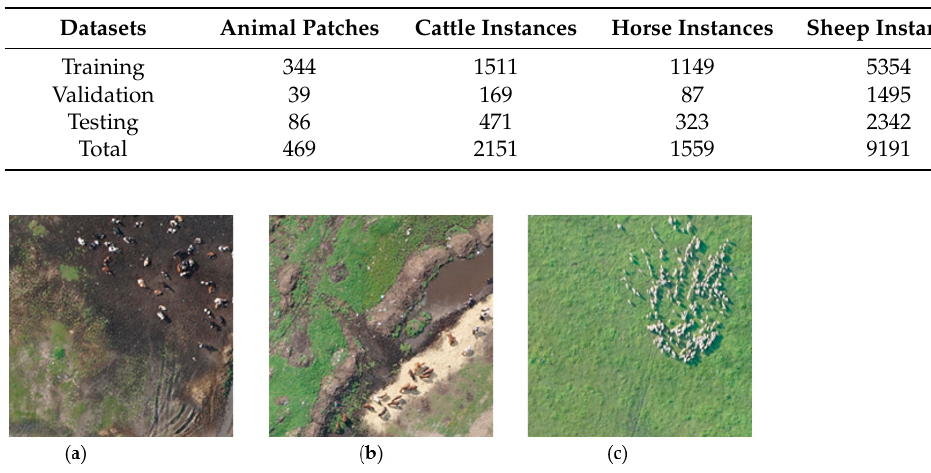
Figure 3. Dataset image. ( a ) A patch of cattle; ( b ) a patch of horses; ( c ) a patch of sheep.